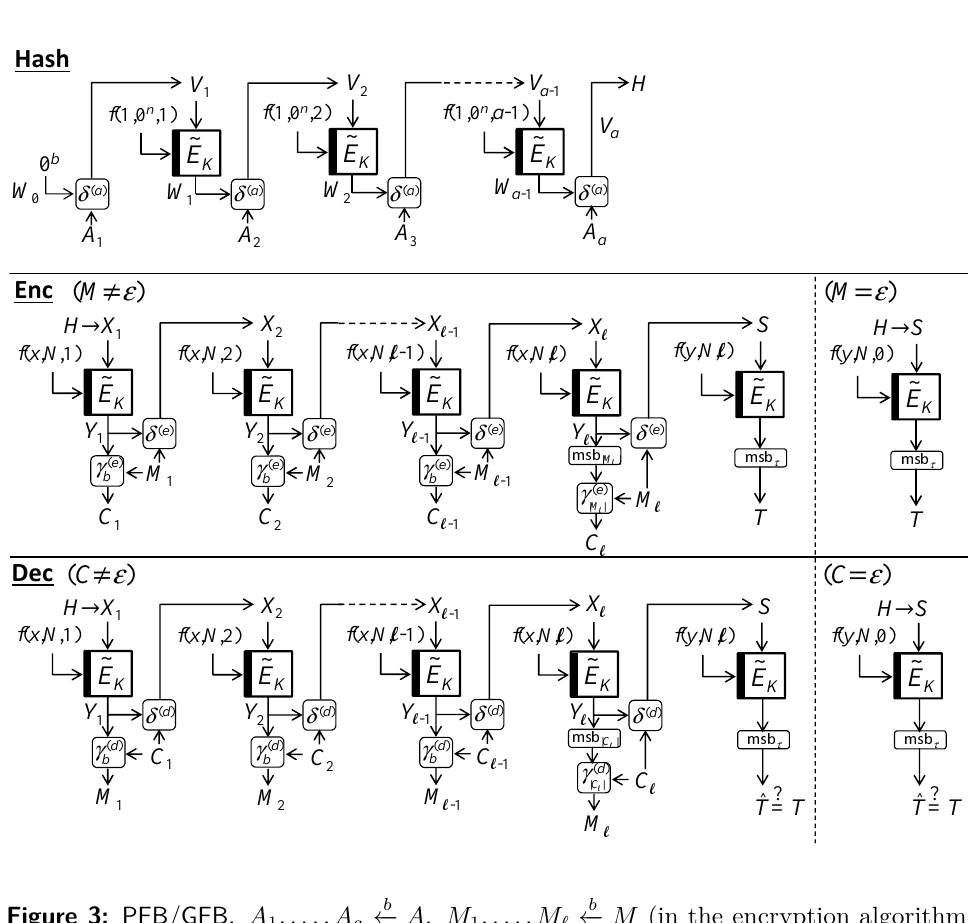
Figure 3: PFB / GFB . A 1 , . . . , A a b ←− A . M 1 , . . . , M ‘ b ←− M (in the encryption algorithm) b ←− C (in the decryption algorithm). If A 6 = ε ∧ | A | mod b = 0 then x ← and C 1 , . . . , C ‘